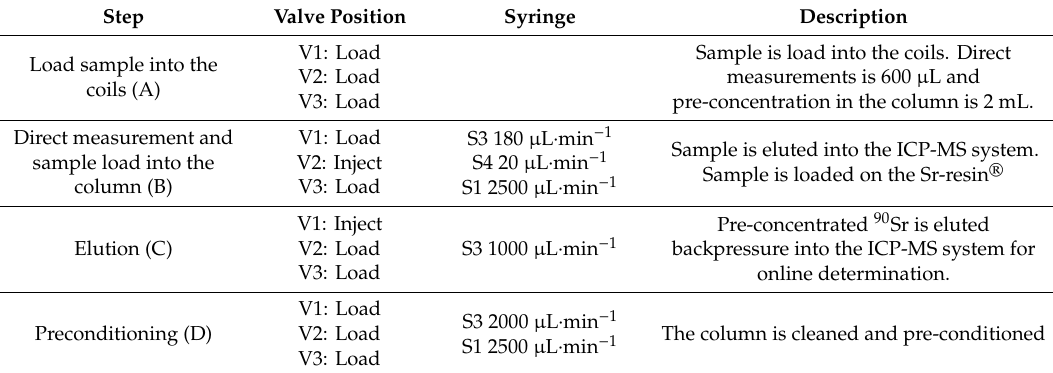
Table 5. SeaFAST set-up with the NexION 300S DRC ICP-MS